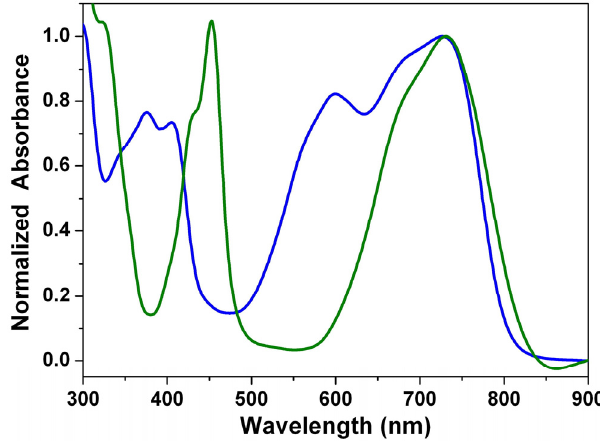
Figure 10. Normalized absorption spectra of 1a and 2a in neat